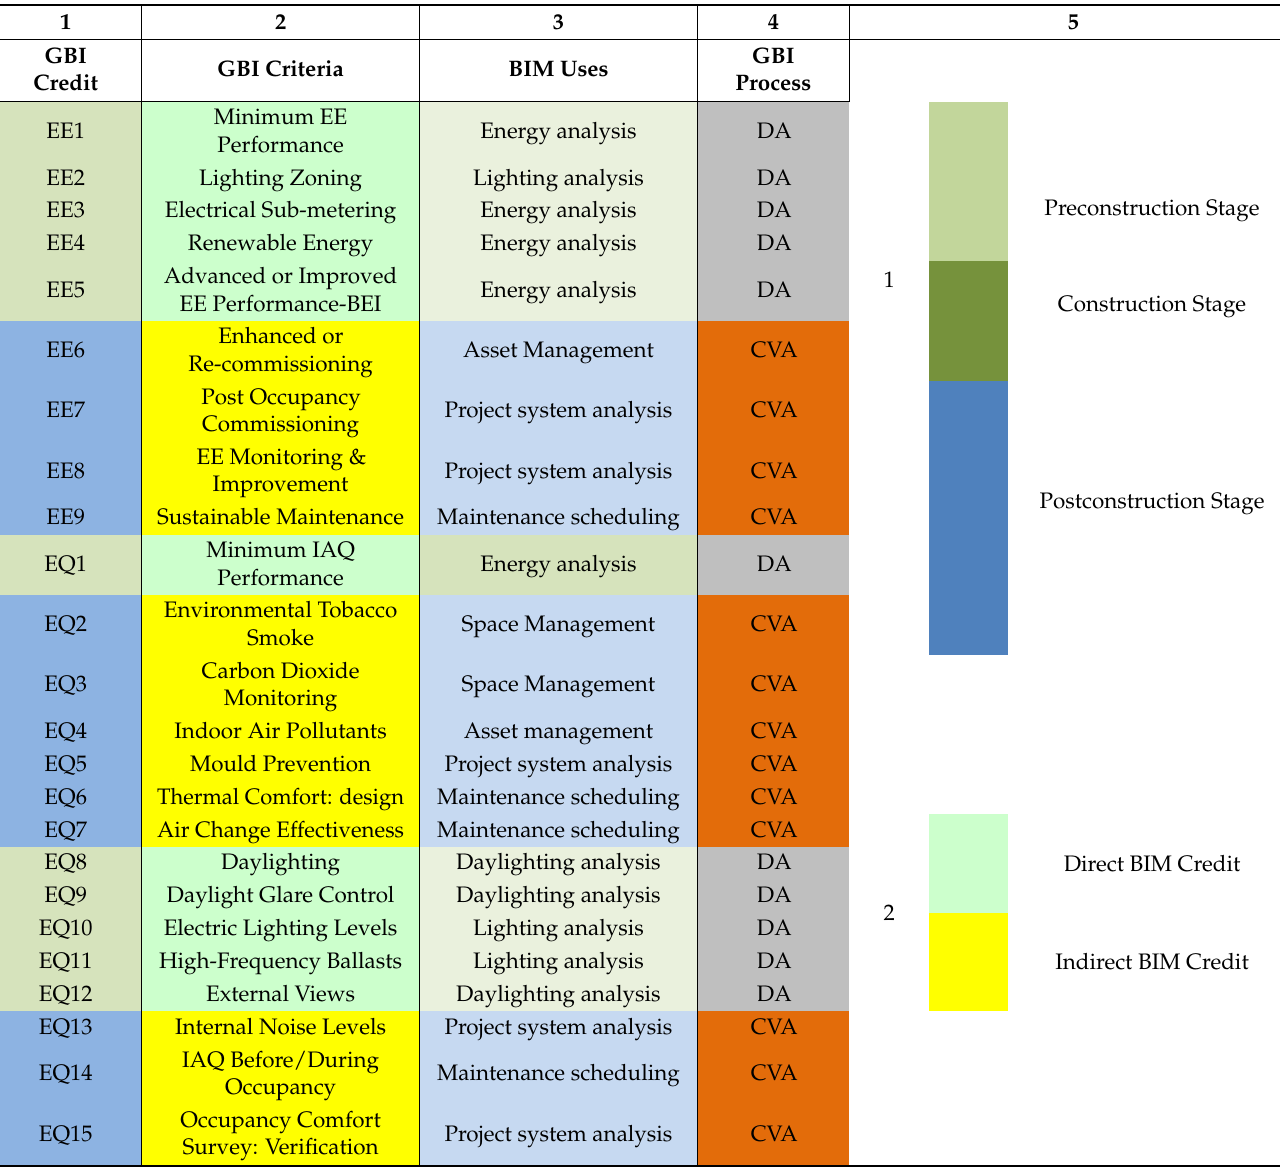
Table 2. BIM-GBI Assessment